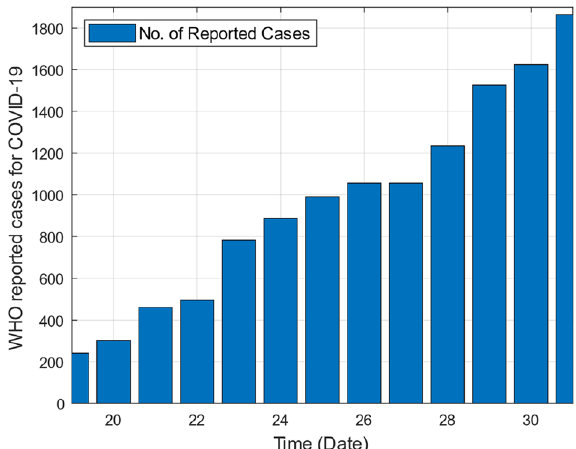
Figure 2. WHO reported cases for COVID-19 from 19th March 2020 till 31st March 2020.